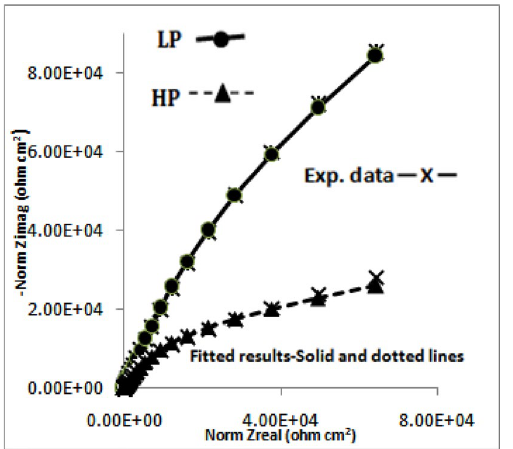
Figure 14. Electrochemical impedance plots in Nyquist form for HP and LP steel bars after 24 h of their exposure in chloride free SPSL.